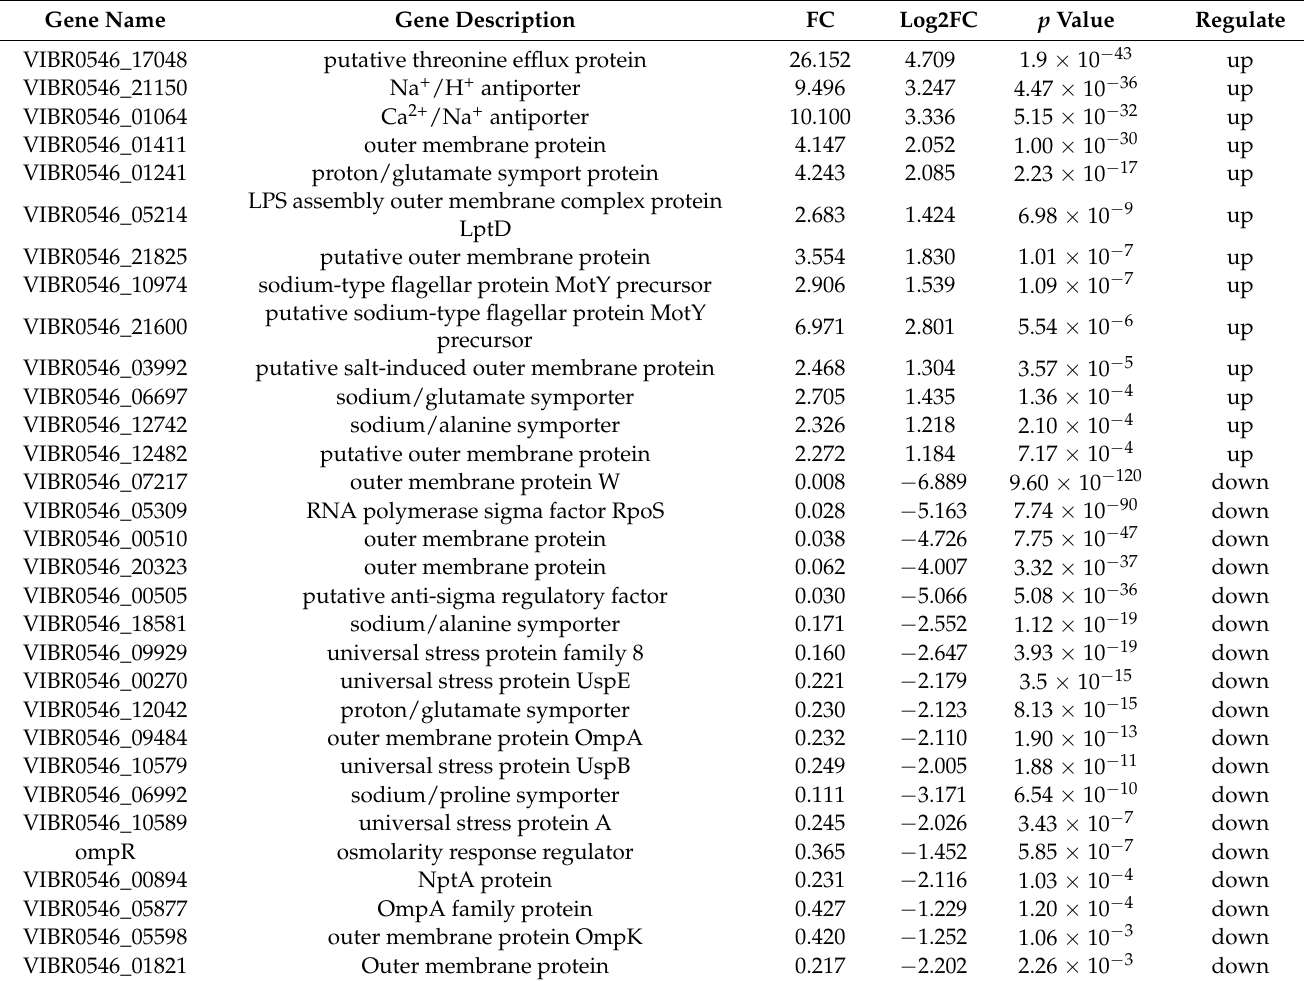
Table 3. The up and down-regulated genes of V. brasiliensis cultured in 7% NaCl